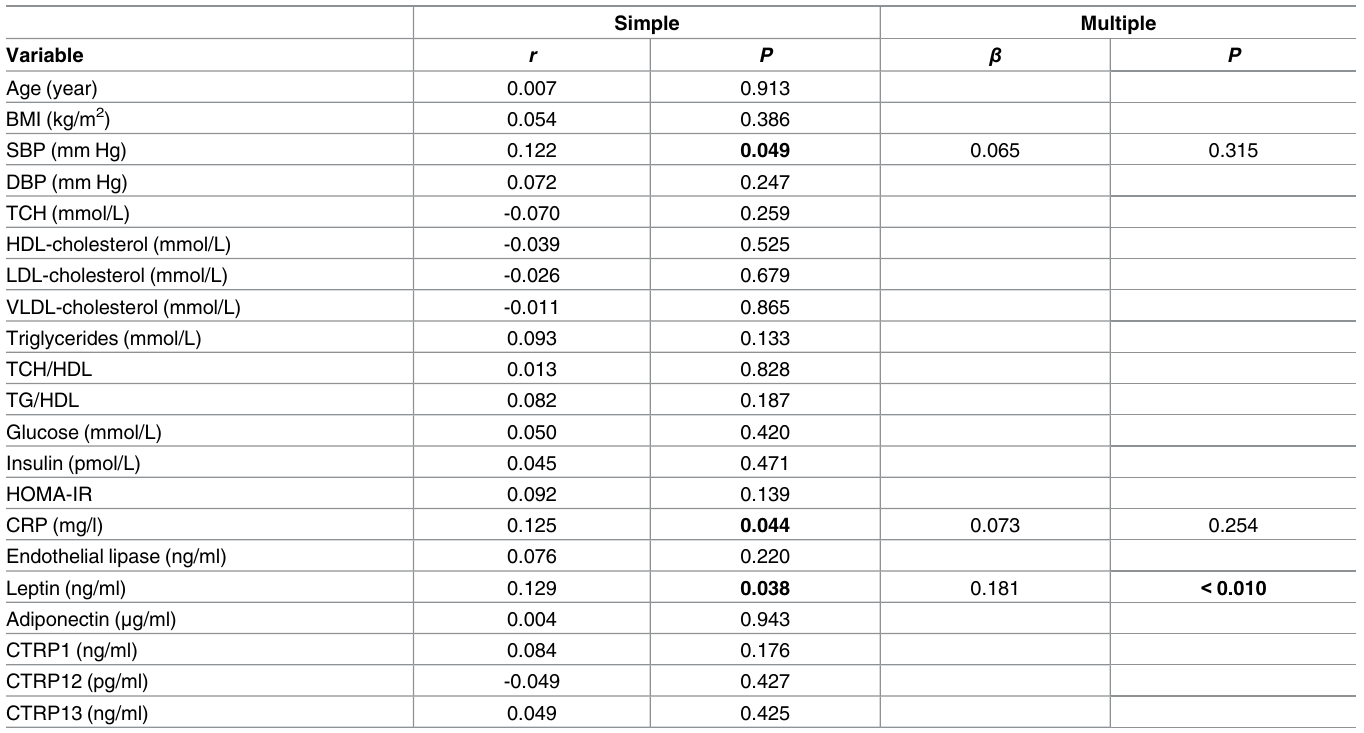
Table 4. Linear regression analysis of variables associated with CTRP9 ( n = 262).